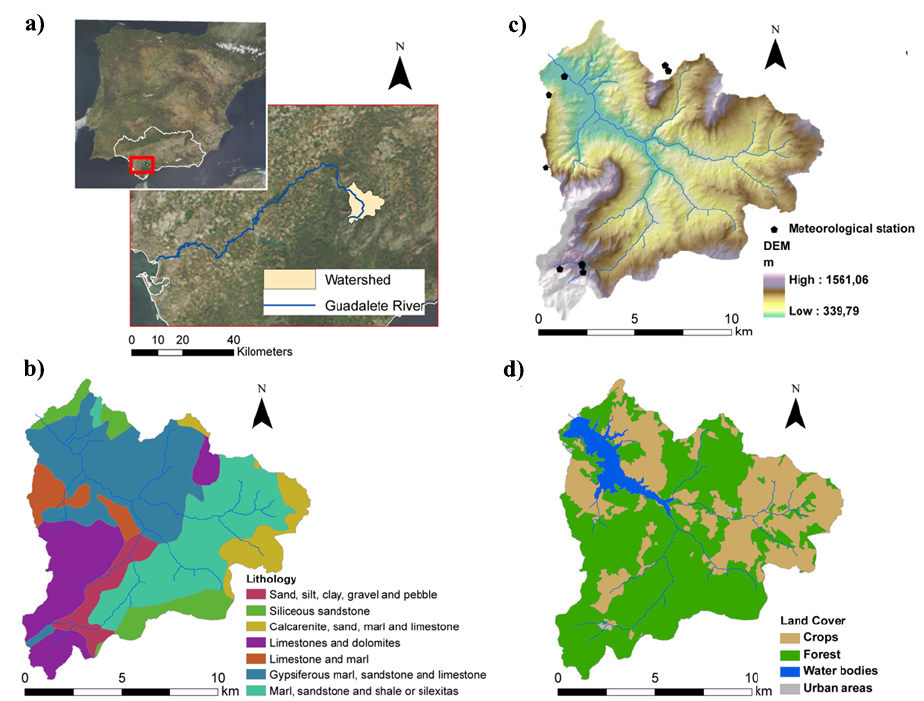
Fig. 1. (a) Location of Zahara watershed in Spain; (b) DEM with meteorological stations; (c) lithology and (d) land